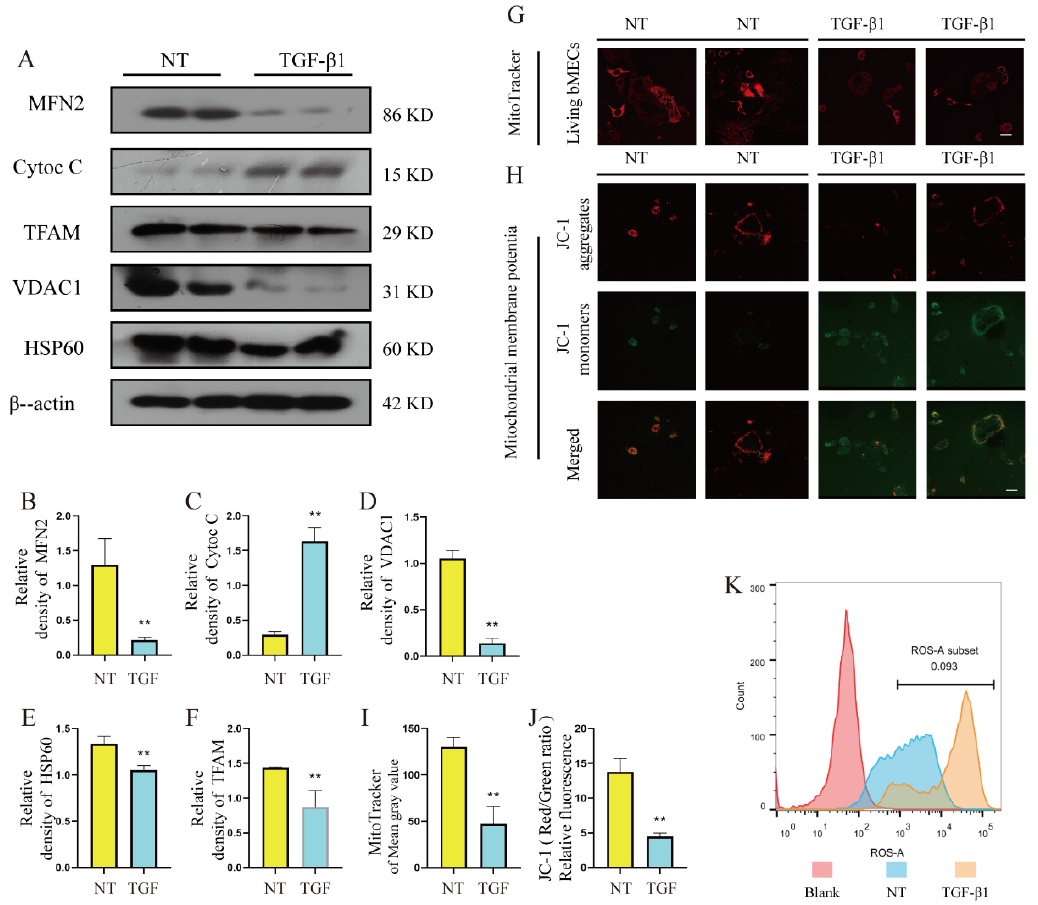
Figure 6. Changes of mitochondrial damage in TGF- β 1-induced bMECs. TGF- β 1 was added to DMEM culture without FBS to stimulate bMECs for 48 h, and then the cells were collected for sub- sequent experiments. ( A ) The protein levels of MFN2, Cyto C, TFAM, VDAC1, HSP60, and β -actin in bMECs. ( B – F ) Quantification of MFN2, Cyto C, TFAM, VDAC1, HSP60 protein levels in bMECs. ( G ) MitoTracker Red CMXRos staining of bMECs, the faint red light means that the number and function of mitochondria are reduced, scale bar 60 μ M. ( H ) Detection of mitochondrial membrane potential of bMECs, stained with JC-1s, scale bar 40 μ M. ( I ) Average fluorescence intensity analysis of MitoTracker in ( G ). ( J ) Quantitative analysis of mitochondrial membrane potential detection with JC-1. ( K ) Flow cytometry detects the production of ROS produced by cells. Data were analyzed by the unpaired t -test method. The data error is presented in the form of mean ± SEM. The results of the experiment are the result of three independent repeated experiments. ** p < 0.01 compared with the control group.